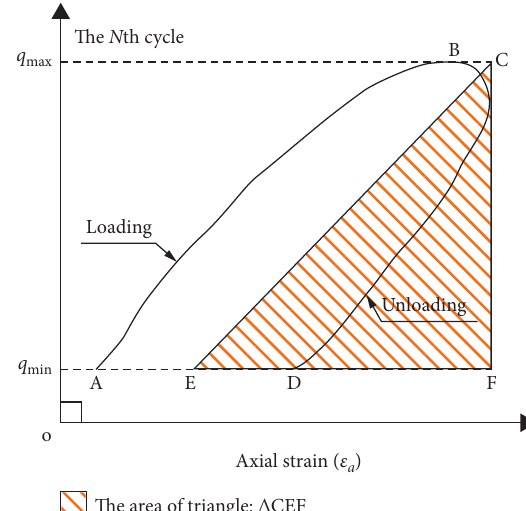
Figure 10: The calculation method of damping ratio for frozen